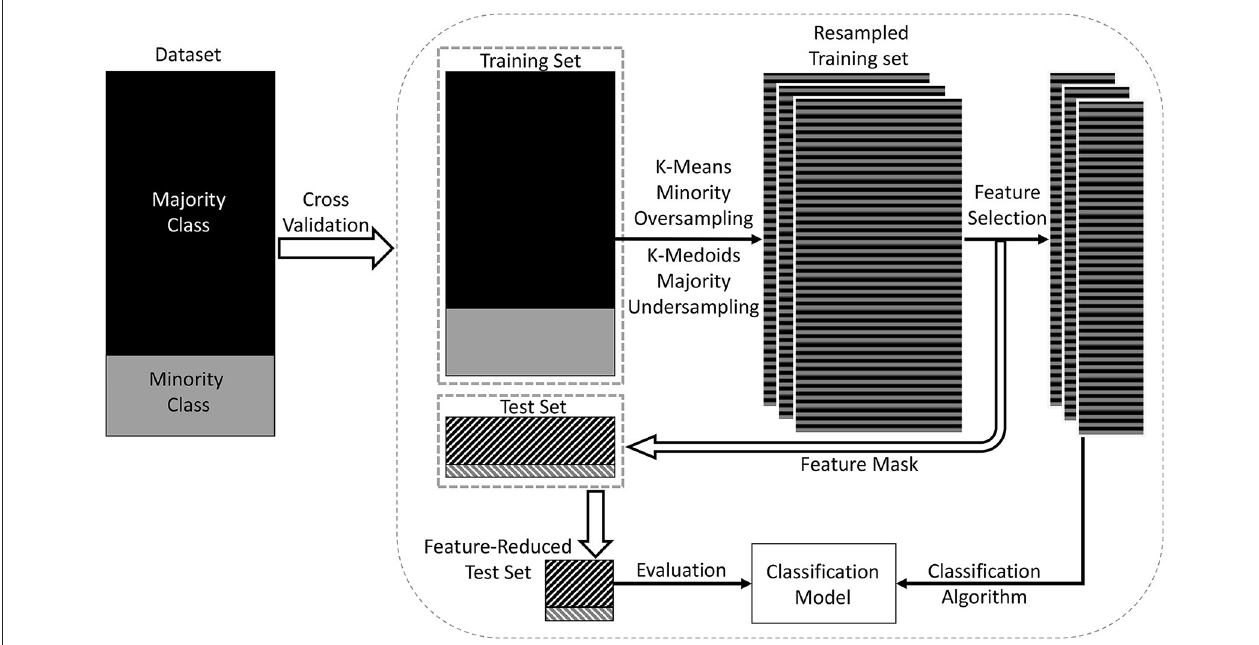
FIGURE 2 | Overview of the proposed classification model. In this model, a training set and a test set were derived from the dataset using data points from both majority and minority classes (shown in the left rectangle of the figure). A combination of oversampling and undersampling technique was applied to the training set to generate a resampled training set. The training set in each cross-validation iteration was resampled three times to reduce the bias due to random dataset generation. Then feature selection was applied to select the most discriminative features. Then the classification model was trained on the dimension-reduced training set, and evaluated on the test